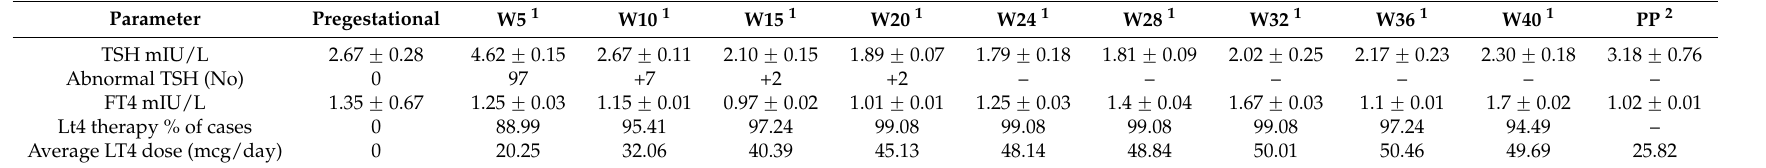
Table 1. Development and evaluation of SCH in women with pre-gestational euthyroid autoimmune thyroid